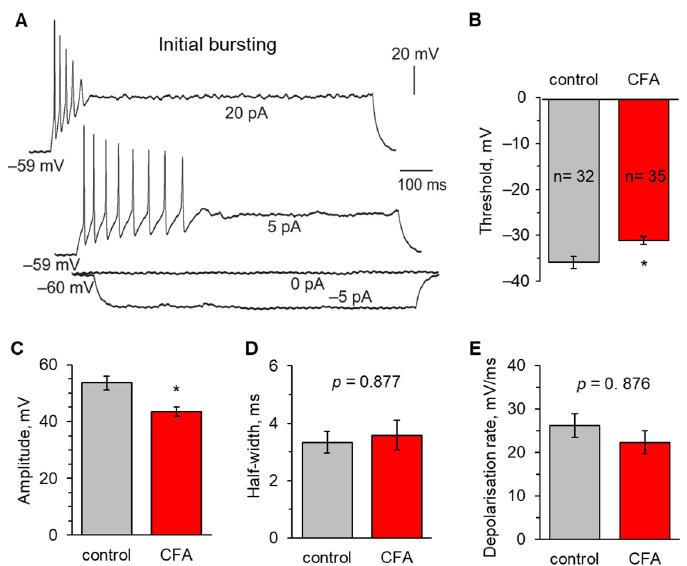
Figure 5. Peripheral inflammation increases the excitability of initial bursting lamina I − II DH neurons. ( A ) An example of current-clamp recordings from a neuron displaying an initial bursting firing pattern in response to a stepwise increase in depolarising currents of the indicated intensity. ( B ) Peripheral inflammation shifts the AP threshold to more depolarised values. ( C ) Peripheral inflammation decreases the AP amplitude in initial bursting neurons. ( D , E ) Statistical summary of the kinetics of APs analysed for the half-width ( D ) and the depolarisation rate ( E ) in the control and inflamed groups. All data are means with SEM; the number of recorded cells is indicated. * p < 0.05 (unpaired two-tailed t